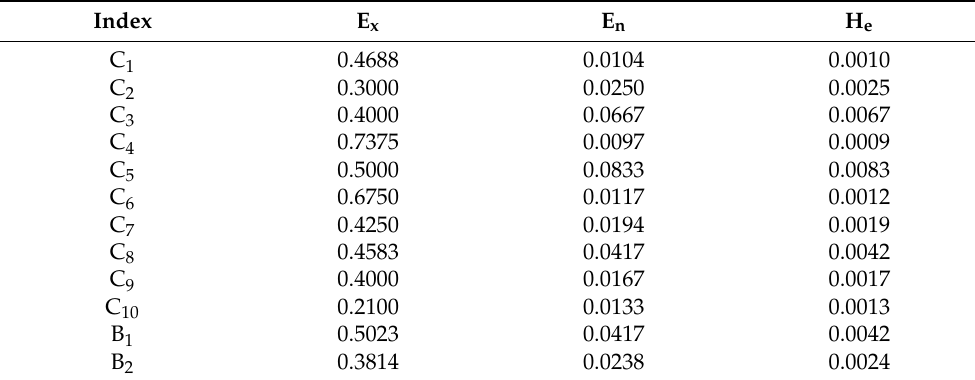
Table 8. Digital characteristics of second-level indexes.